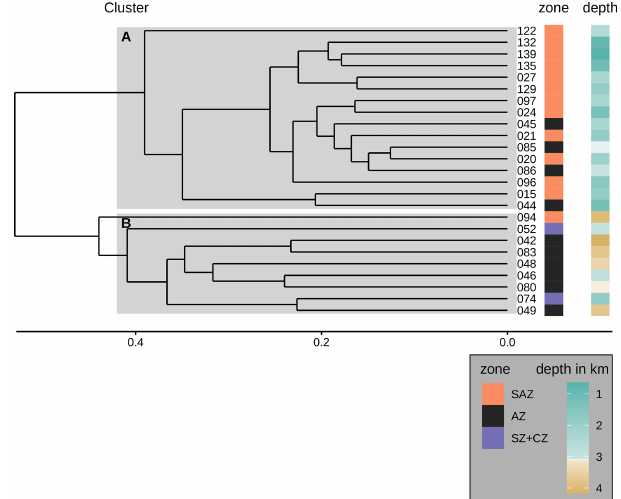
Figure 9. Dendrogram presenting the hierarchical clustering (av- erage linkage) of the species assemblages in the surface sediment samples. The samples were clustered into two groups A and B as suggested by the majority of 30 indices (see Sect. 3). Cluster A con- sists of all but one sample from the SAZ and some samples from the AZ that stem from water depths above 3.1km. Cluster B consists of all samples from the AZ that lie below 3.1km water depth (except sample PS97/046-6, which stems from a water depth of 2.8km), the two samples from the SZ + CZ and one deep sample from the SAZ (PS97/094-1). Note the frontal zone and the water depth of the respective samples on the right-hand side of the